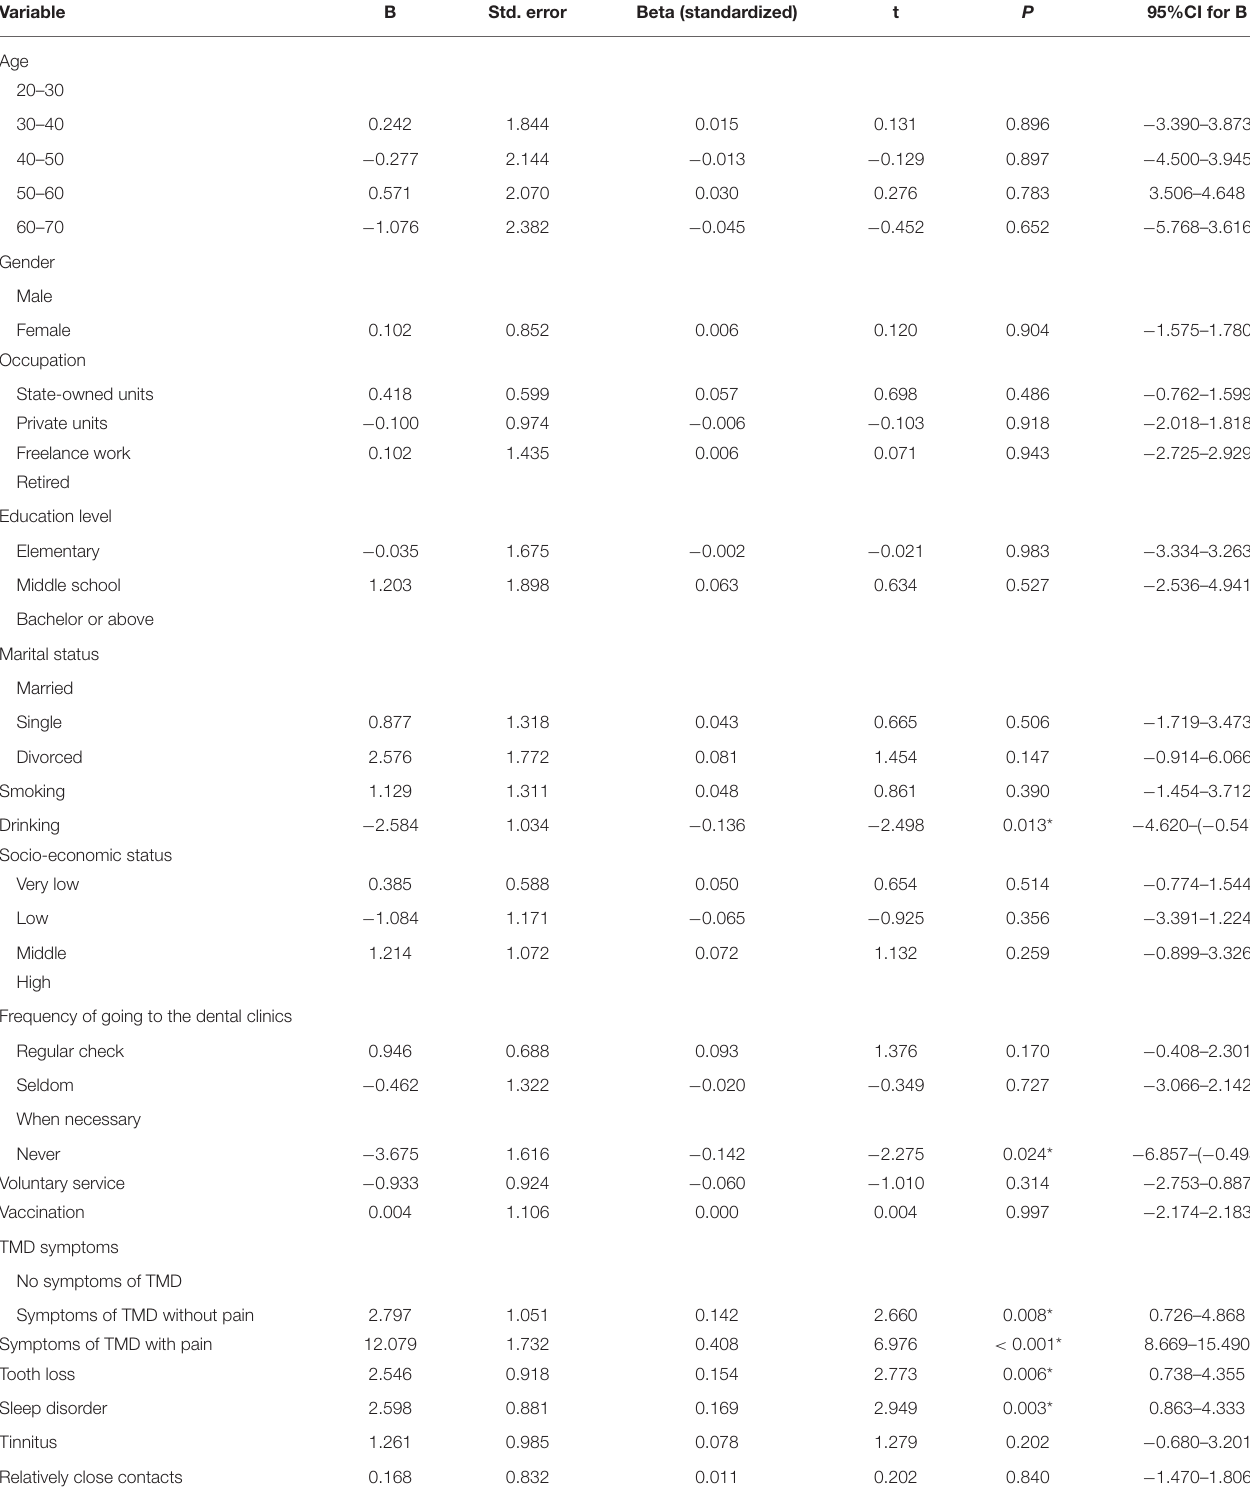
TABLE 5 | Factors associated with